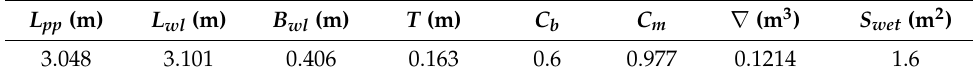
Table 9. Main scale factors of the standard ship model, Series